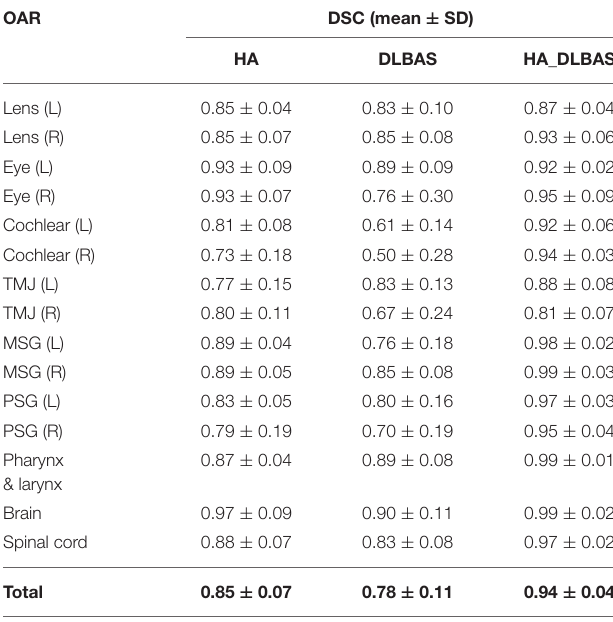
TABLE 5 | Dice similarity coefficient by three contouring methods of the clinical test set. OAR DSC (mean ± SD) HA DLBAS